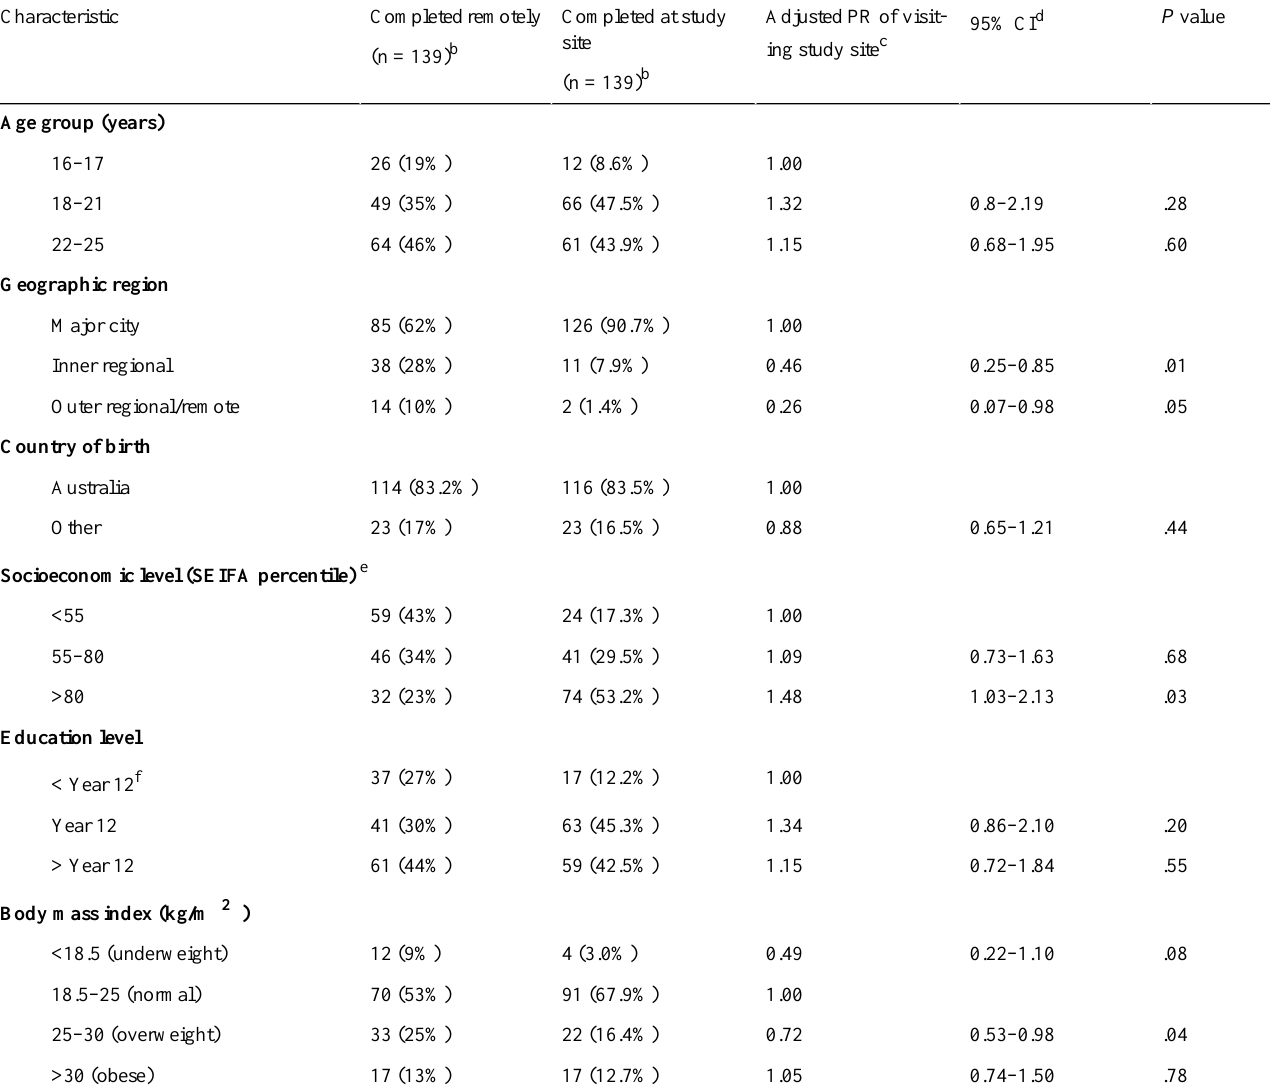
Table 4. Associations between completing a the survey at the study site and completing it remotely, by sociodemographic